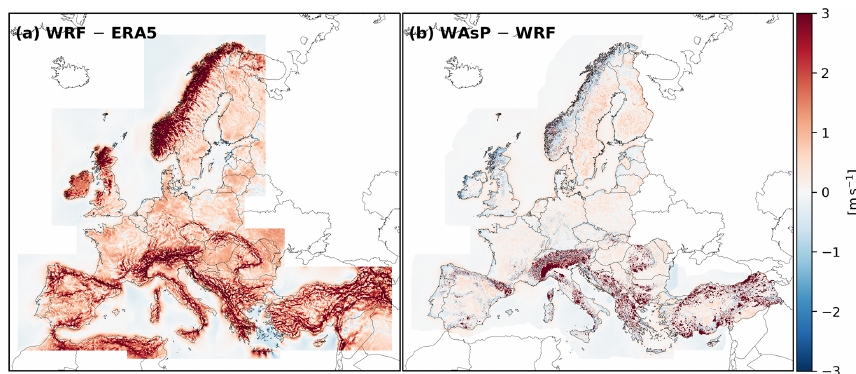
Figure 7. Mean wind speed differences for WRF minus ERA5 (a) and WAsP minus WRF (b) at 100ma.g.l. averaged over the full 30-year period (1989–2018). Note that the lower resolution data were interpolated bi-linearly to the grid of the dataset with higher resolution. The difference between WAsP- and WRF-derived winds was calculated on a down-sampled version of the WAsP grid with a grid spacing of 500m × 500m.